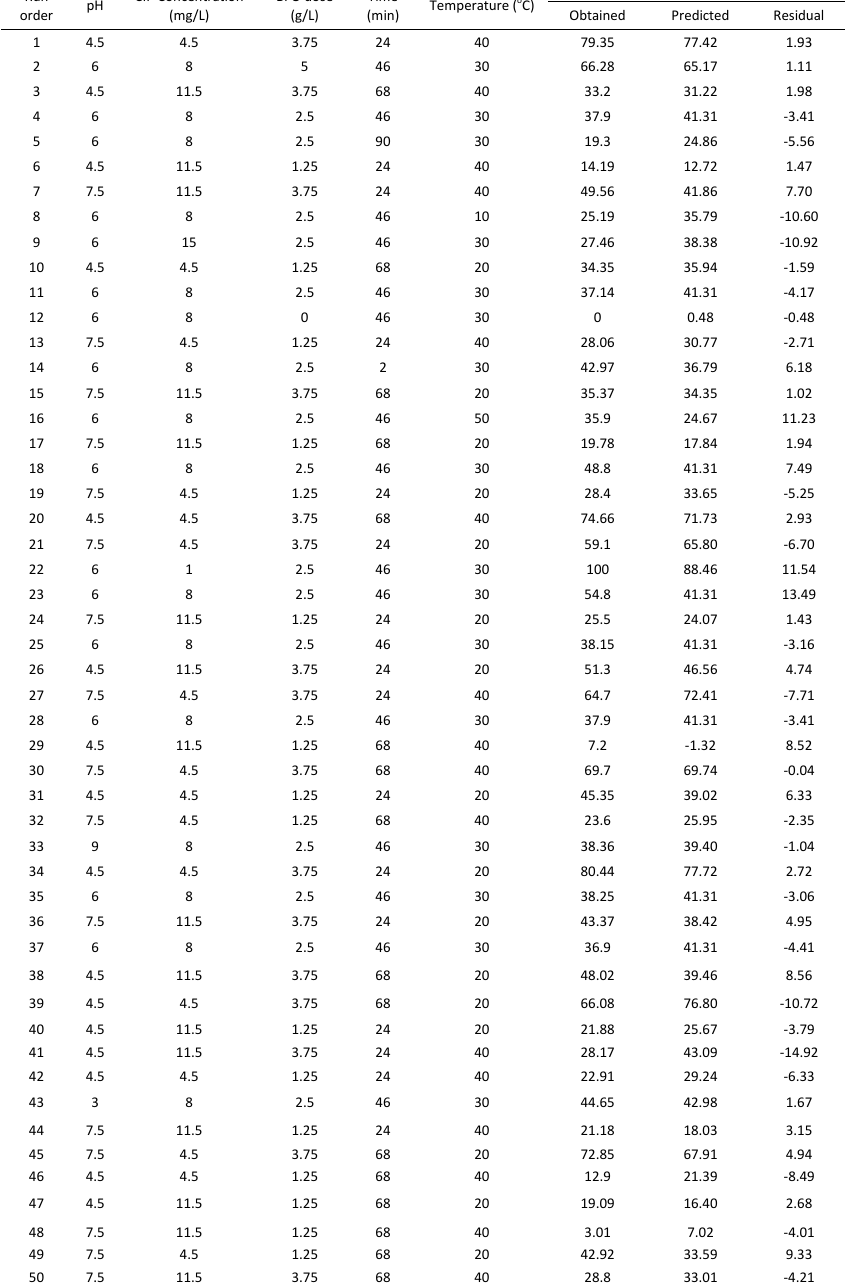
Table 2: The 5-factor CCD matrix with coded factor levels for CIP removal based on RSM